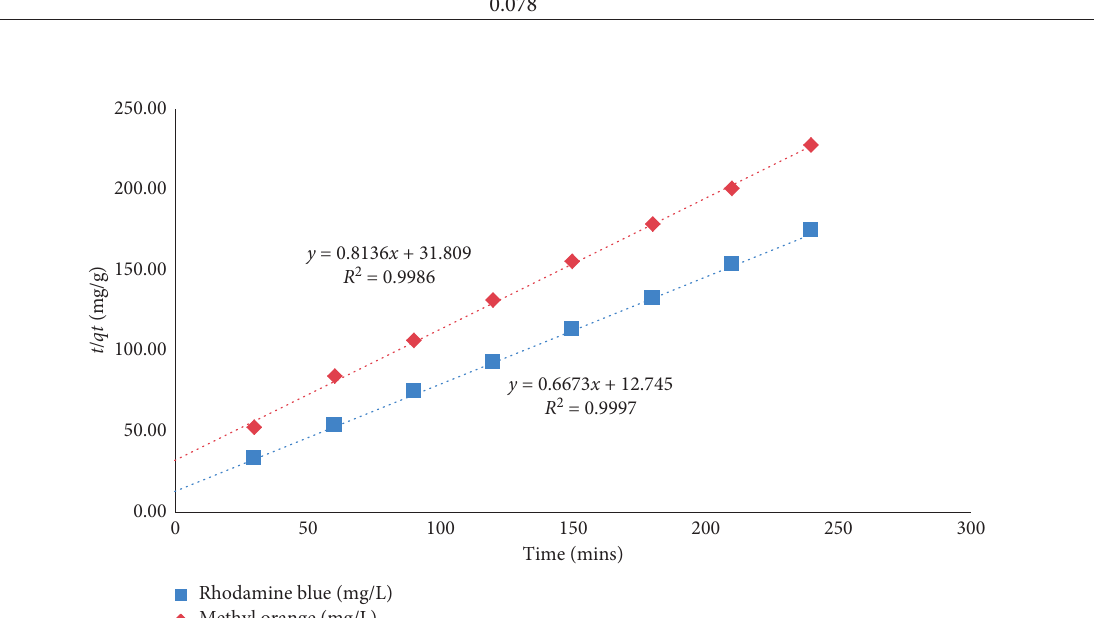
Figure 17: Pseudo-second-order degradation reaction of rhodamine blue and methyl orange.